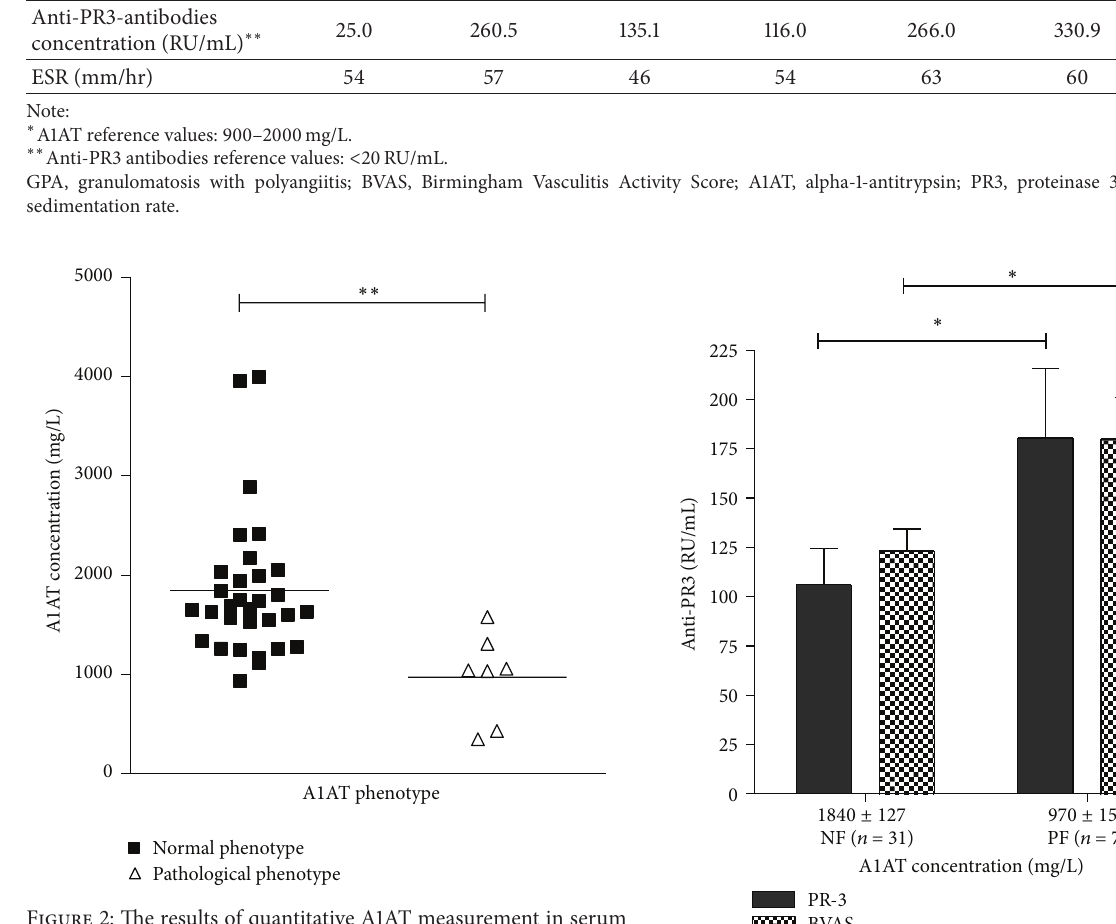
Figure 2: The results of quantitative A1AT measurement in serum samples of GPA patients with normal and pathological A1AT